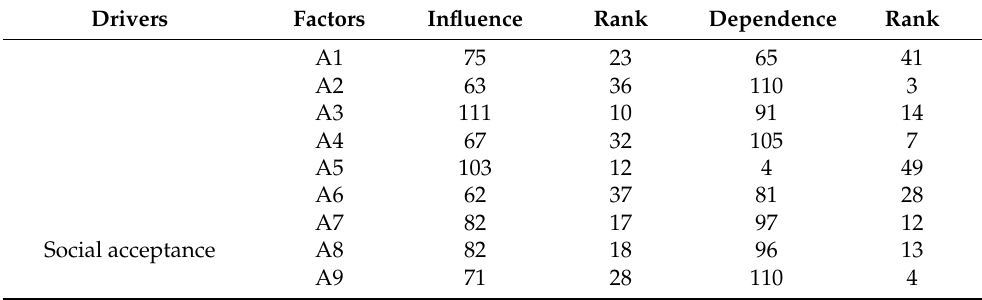
Table 4. Ranking of long-listed factors based on the degree of influence and